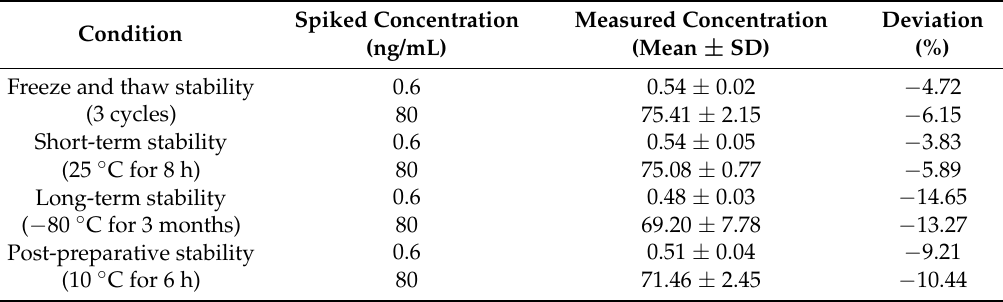
Table 2. Stability of KAU under various conditions.